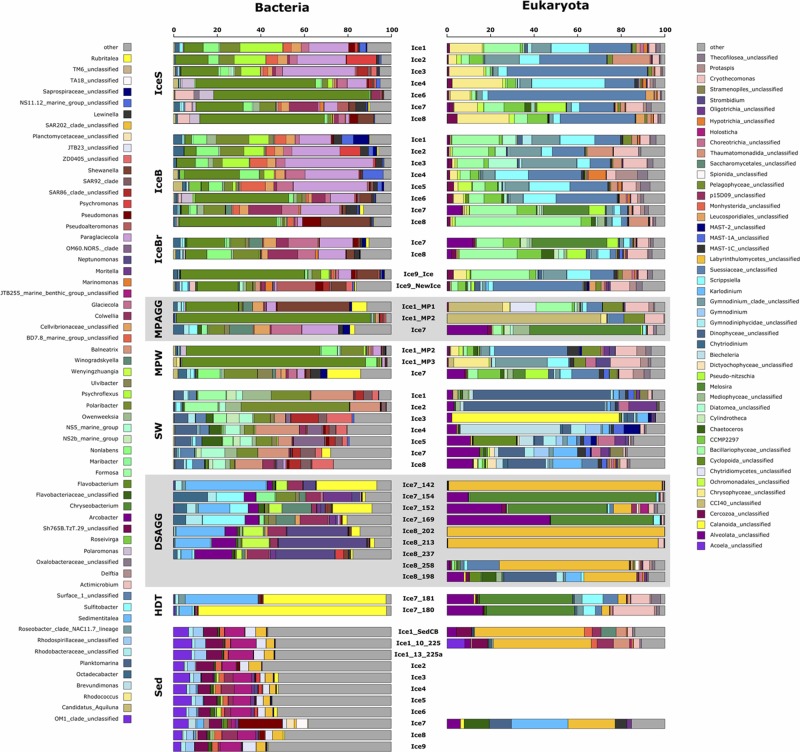
Dominant bacterial and eukaryotic genera in a range of environments across the Eurasian basin of the Arctic Ocean. Shown are the five most abundant genera across all samples, based on relative sequence abundance. Samples are grouped by environment and corresponding samples from the bacterial and eukaryotic dataset are plotted next to each other. IceS, sea-ice surface; IceB, sea-ice bottom; IceBr, brownish-colored sea ice; MPAGG, melt-pond aggregate; MPW, melt-pond water; SW, surface seawater; DSAGG, deep-sea algae deposit; HDT, holothurian digestive tract content; Sed, deep-sea surface sediment.